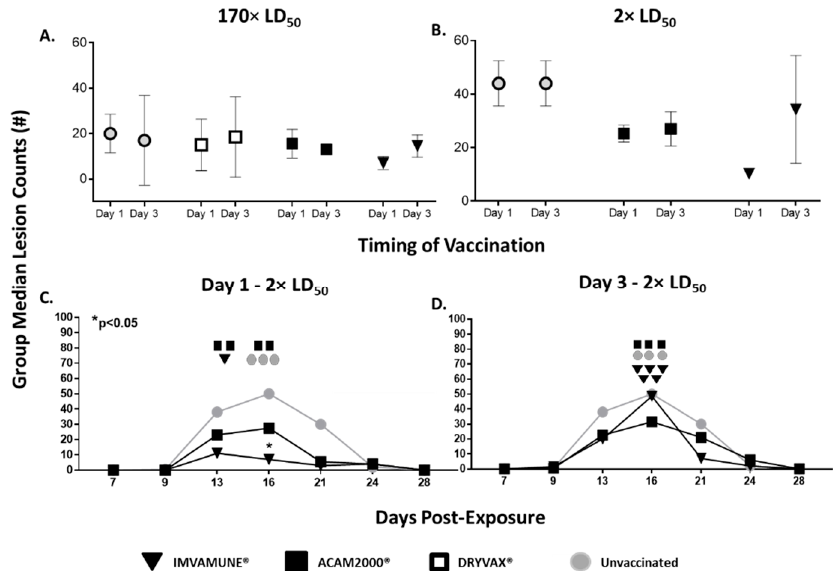
Figure 4. Rash burden. Group median peak (Day 16) lesion counts are shown for all animals that received 170 × LD 50 MPXV dose ( A ) and 2 × LD 50 ( B ) for both Day 1 (left symbol) and Day 3 (right symbol) for all groups—unvaccinated (gray circles), Dryvax ® -vaccinated (white square – 170 × LD 50 study only) ACAM2000 ® -vaccinated (black squares) and IMVAMUNE ® -vaccinated animals (black triangles). No significant differences were seen between vaccine group or vaccination timing by two-way ANOVA ( p < 0.05). Group median secondary lesion counts at each time-point are shown for animals challenged with 2 × LD 50 dose of monkeypox virus and either unvaccinated (gray circles) or vaccinated 1 day postexposure ( C ) or 3 days postexposure ( D ) with ACAM2000 ® (black squares) or IMVAMUNE ® (black triangles). Euthanized animals for each vaccine group are indicated on the day of euthanasia (same symbols as above). Only animals vaccinated with IMVAMUNE ® on Day 1 postexposure differed significantly from unvaccinated controls by two-way ANOVA ( p < 0.05).